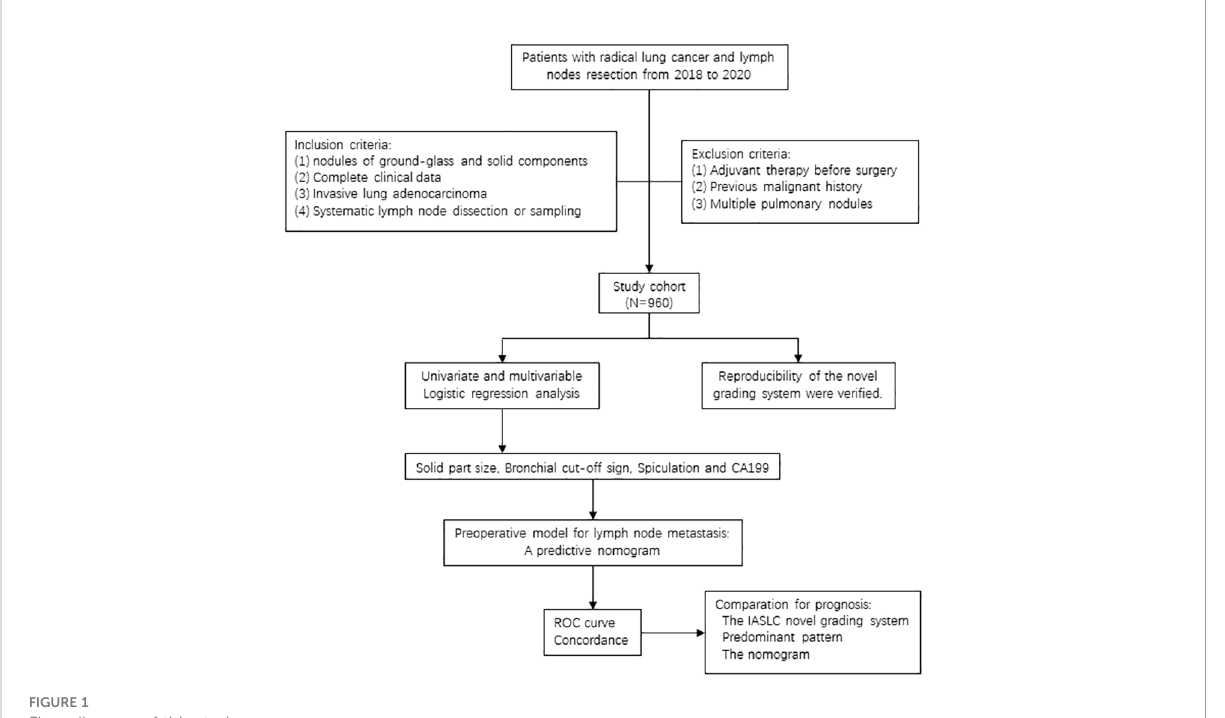
FIGURE 1 Flow diagram of this